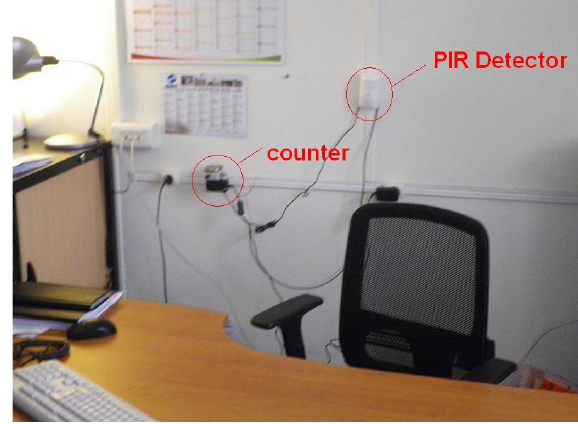
Fig. 4. Inputs and outputs detection with infrared barriers.